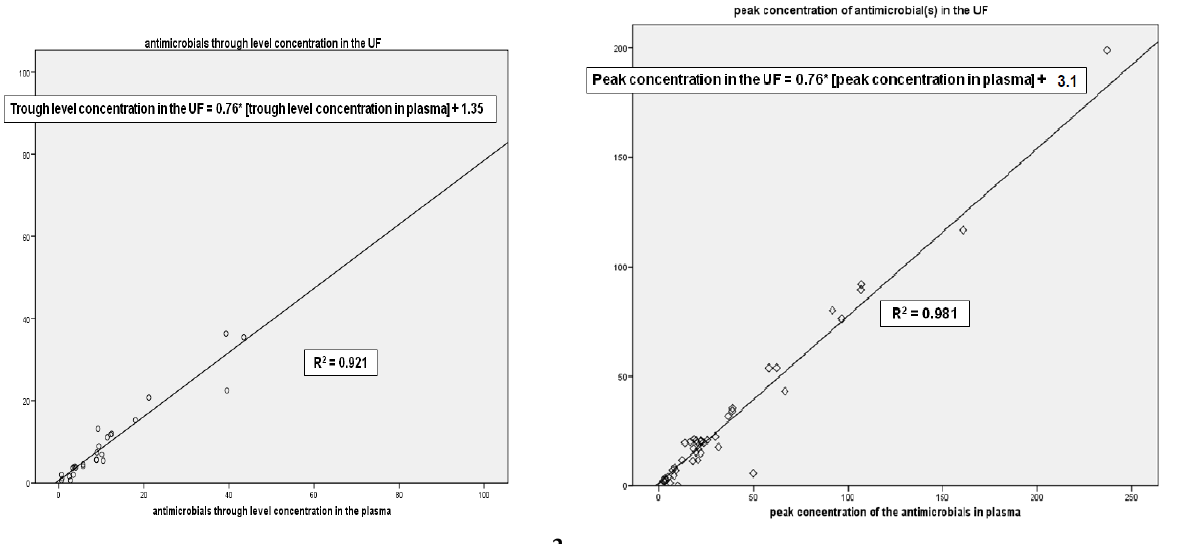
Figure 3. Lines and regression coefficient of the concentration of antibiotics in plasma in UF at the trough levels and peak concentration. * Multiplication sign.